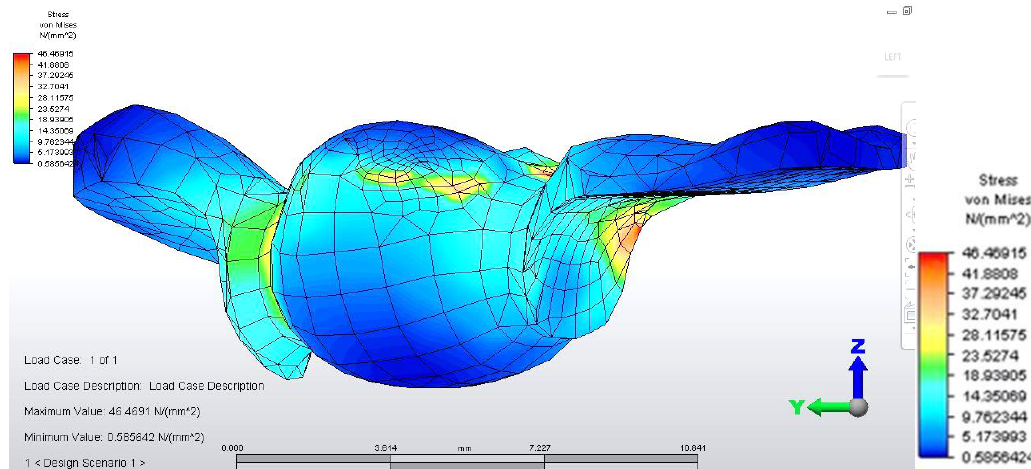
Figure 4. Tension distribution at the bridge level in three directions: axonometric, right and left, when the force is placed in the 3.5 area.